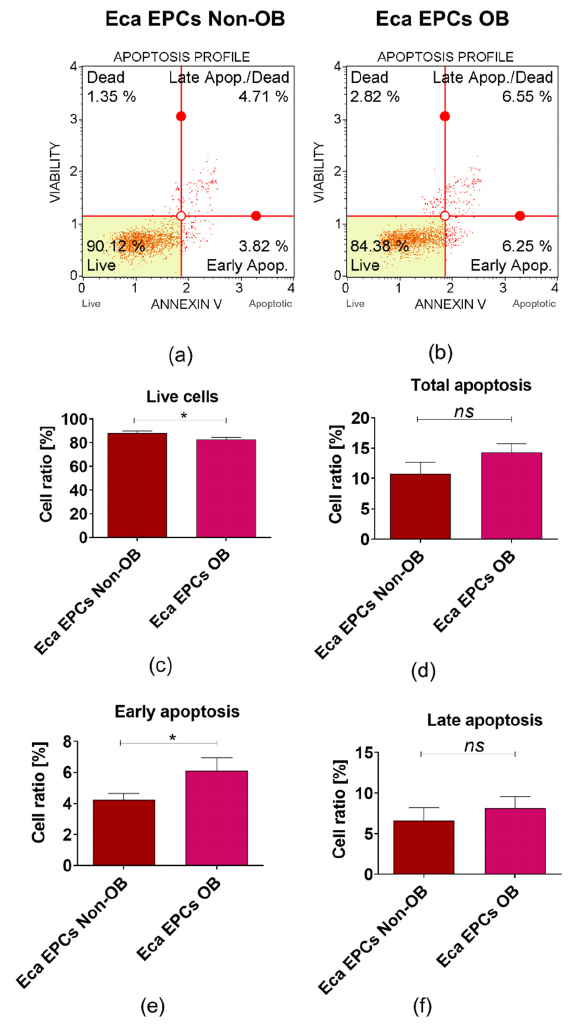
Figure 10. The apoptosis profile determined in equine endometrial progenitor cells (Eca EPCs) isolated from non-obese mares (non-OB) and obese mares (OB). The representative graphs show the distribution of cells, taking into account their viability ( a , b ). The viable cells are noted in the left bottom corner (Live), early apoptotic cells are located in the right bottom corner. Late apoptotic cells are visible in the right upper corner, while necrotic cells (dead) are in the left upper corner. The total apoptotic cells percentage reflects the sum of early and late apoptotic cells. Comparative analysis was performed to determine differences between Eca EPCs non-OB and OB for viability ( c ) total cell apoptosis ( d ) early apoptosis ( e ) and late apoptosis ( f ). Means ± SD. * p -value < 0.05, while ns symbol refers to non-significant differences.